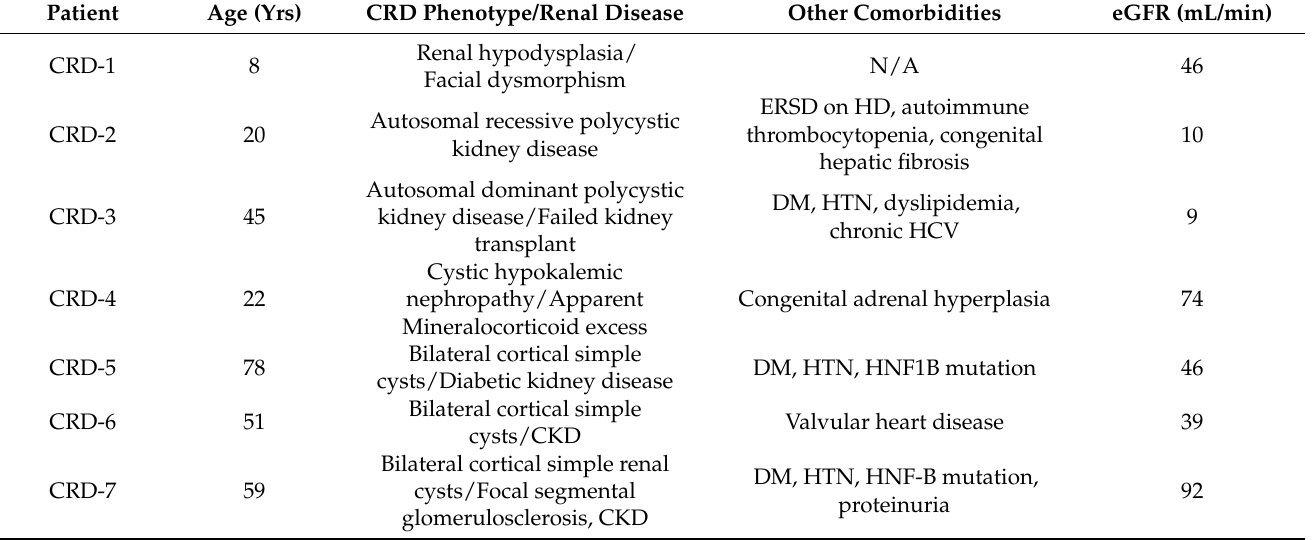
Table 1. Summary of relevant clinical characteristics of patients in CRD group CRD: Cystic Renal Disease; CKD: Chronic Kidney Disease; DM: diabetes mellitus; eGFR: estimated glomerular filtration rate; ESRD: End-Stage Renal Disease; HCV: Hepatitis C Virus; HTN: